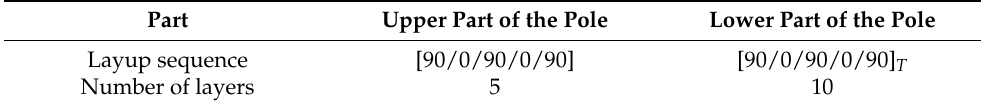
Table 4. Configuration and number of fiber